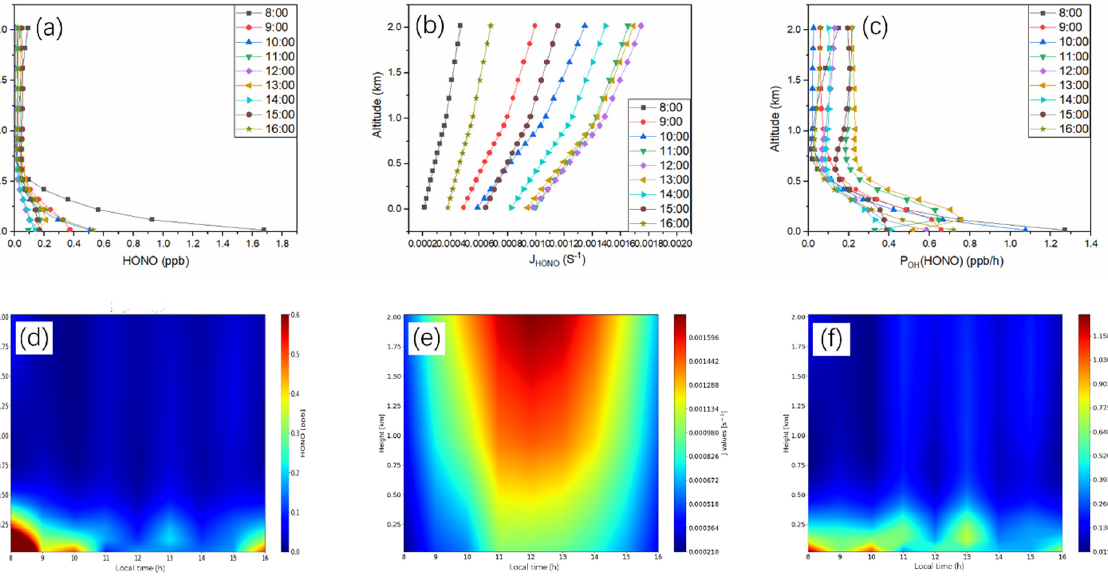
Figure 13. Case analysis of OH production rate from HONO photolysis for a haze day (10 February 2018). ( a – c ) is the correlation between [HONO], J HONO , P OH , and altitude at different times in one day. Different colored lines represent different times. ( d – f ) is the profile of [HONO], J HONO , and P OH respectively.